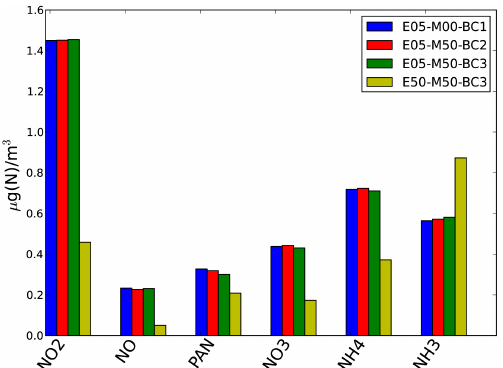
Figure 10. Calculated concentrations of major Nr species from the EMEP MSC-W model for four scenarios. EU28 +